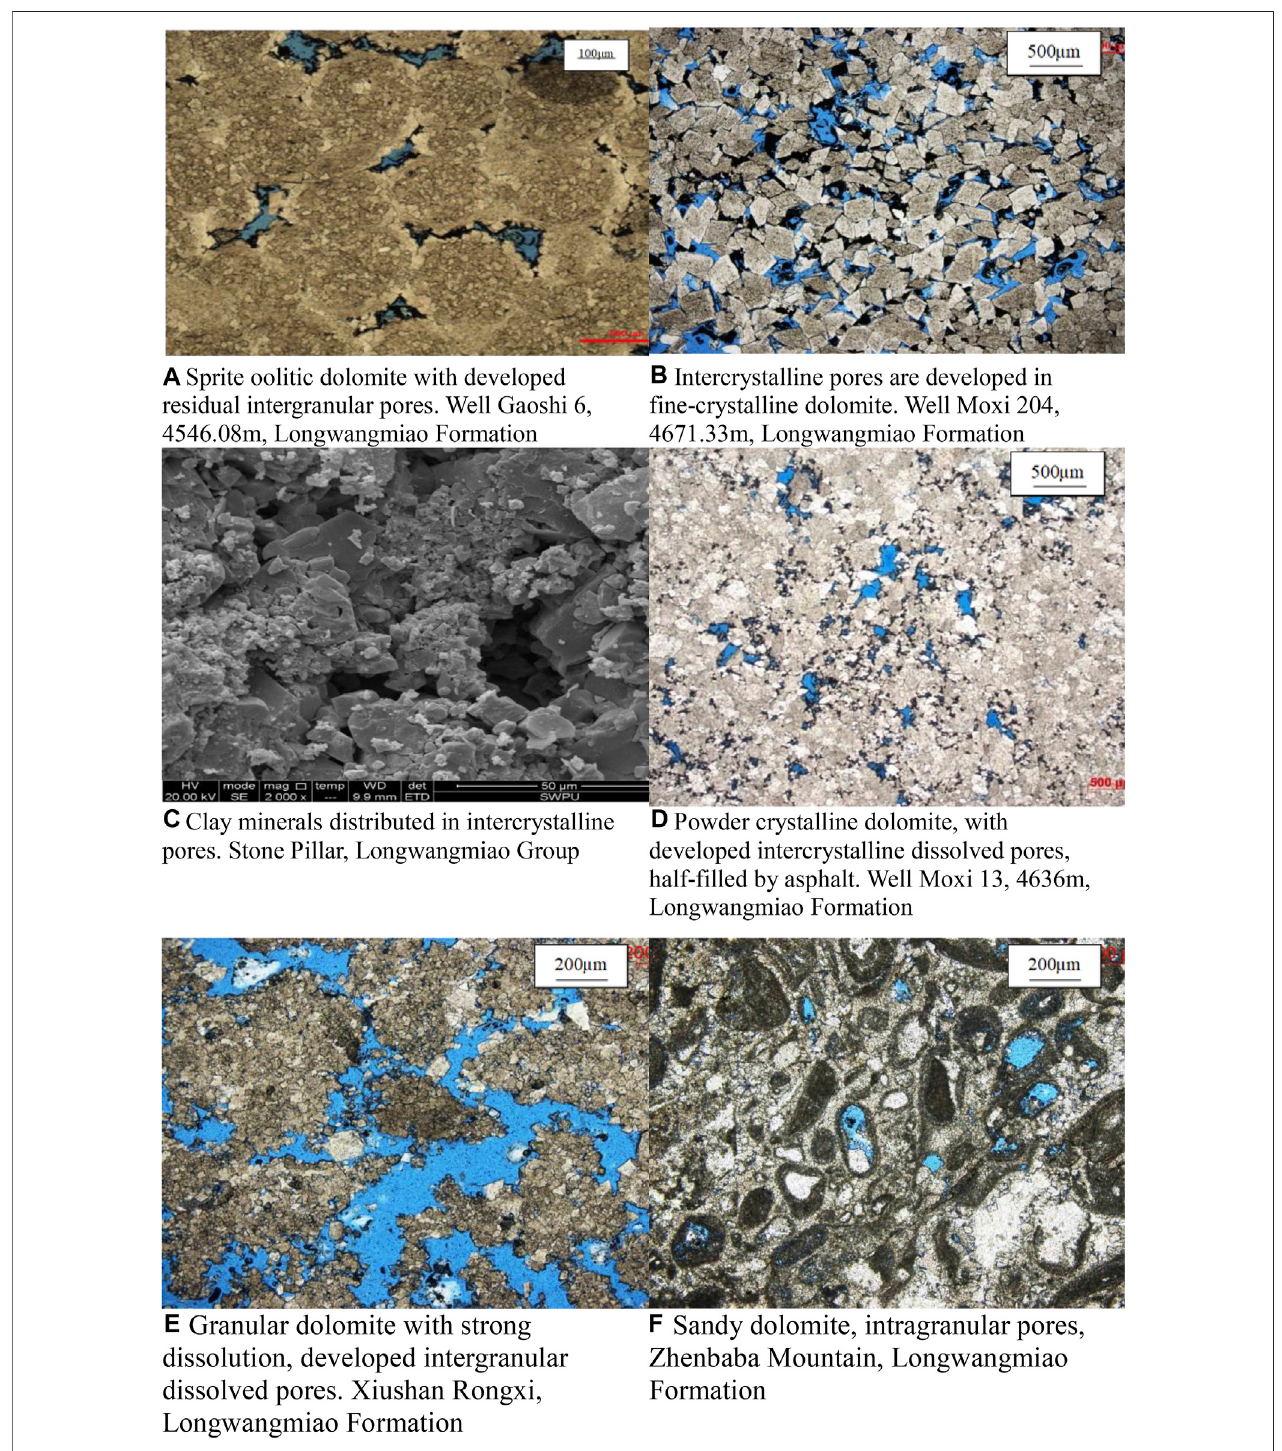
FIGURE6| CharacteristicsofporesandholeinCambrianreservoirsintheSichuanBasin(I). (A) .Spriteooliticdolomitewithdevelopedresidualintergranularpores. Well Gaoshi 6,4,546.08 m, Longwangmiao Formation, (B) . Intercrystalline pores are developed in fi ne-crystalline dolomite. WellMoxi 204, 4,671.33 m, Longwangmiao Formation, (C) . Clay minerals distributed in intercrystalline pores. Stone Pillar, Longwangmiao Group, (D) . Powder crystalline dolomite, with developed intercrystalline dissolved pores, half- fi lled by asphalt. Well Moxi 13, 4636 m, Longwangmiao Formation, (E) . Granular dolomite with strong dissolution, developed intergranular dissolved pores. Xiushan Rongxi, Longwangmiao Formation, (F) . Sandy dolomite, intragranular pores, Zhenbaba Mountain, Longwangmiao Formation.